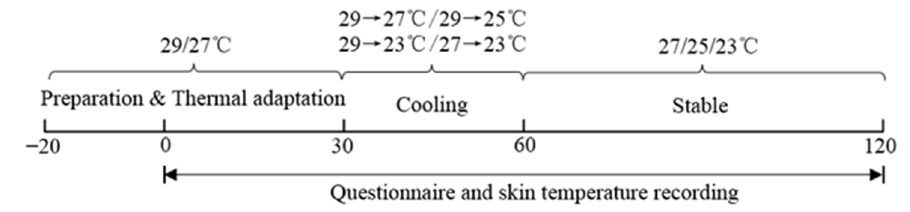
Figure 4. Experimental procedure.